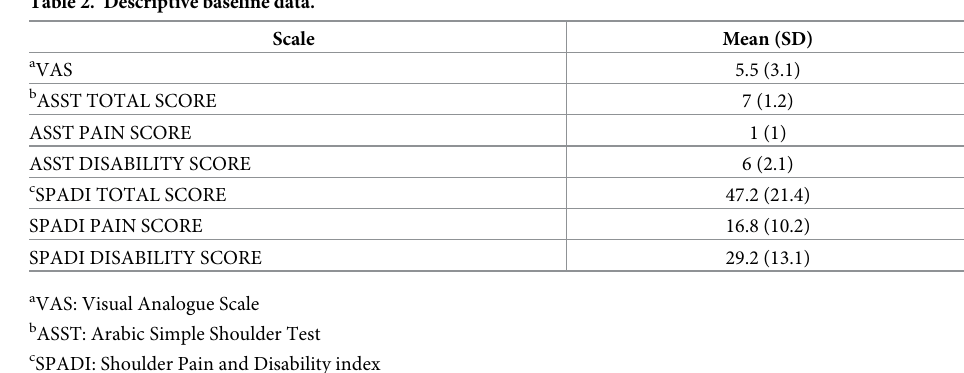
Table 2. Descriptive baseline data.